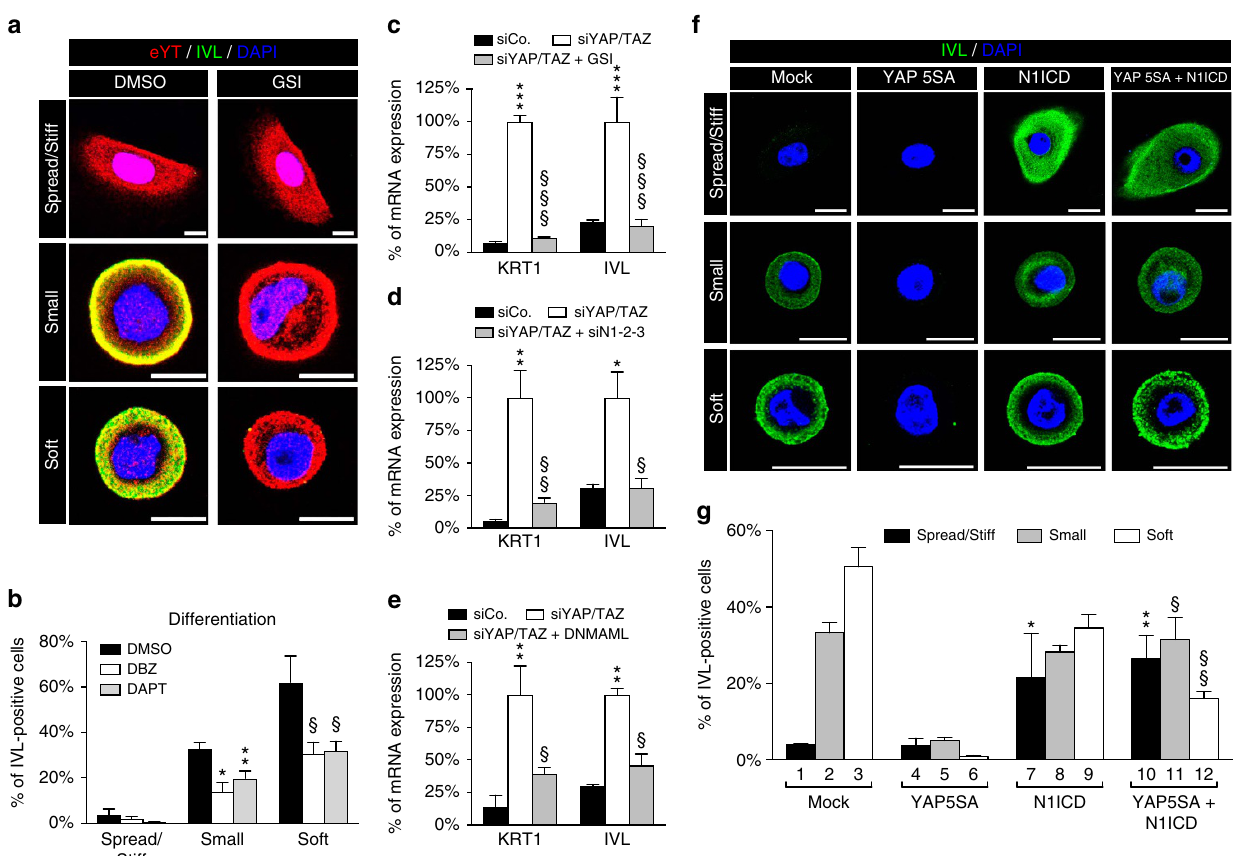
Figure 5 | Notch is epistatic to YAP/TAZ and required for mechano-induced epidermal SC differentiation. ( a , b ) nHEK cells were seeded for 24h on fibronectin-coated coverslips (spread/stiff), fibronectin islands of 300 m m 2 (small) or fibronectin-coated hydrogels of 1kPa (soft) and concomitantly treated with control vehicle (DMSO) or with two independent g -secretase inhibitors (GSIs; DAPT, 20 m M; DBZ, 2.5 m M). ( a ) Confocal images of cells plated as described and stained for endogenous YAP/TAZ (eYT, red), Involucrin (IVL, green) and nuclear compartment (DAPI, blue). Representative images of cells treated with control vehicle (DMSO) or DBZ (GSI) are shown. Scale bar: 20 m m. ( b ) Quantitation of differentiation of data shown in a (as in Figs 1 and 2). Bars represent mean þ s.d. ( n ¼ 3 independent experiments. * P ¼ 0.009 and ** P ¼ 0.0003 compared to DMSO-treated cells on small, y P o 0.0001 compared to DMSO-treated cells on soft; two-way analysis of variance (ANOVA)). ( c – e ) nHEK cells transfected with control (siCo.) or YAP/TAZ siRNAs (siYAP/TAZ) were either treated with DBZ GSI ( c ), cotransfected with a combination of siRNAs targeting Notch1, Notch2 and Notch3 receptors (siN1-2-3) ( d ) or infected with a doxycycline-inducible lentiviral vector encoding the dominant-negative form of MAML1 (DNMAML) ( e ). After 48h from siRNA transfection, cells were analysed by qRT–PCR for KRT1 and IVL . Data were normalized to the control-treated siYAP/TAZ-transfected cells (white bar). Bars represent mean þ s.d. (* P o 0.01, ** P o 0.001, *** P o 0.0001 compared to siCo; y P o 0.01, yy P o 0.001, yyy P o 0.0001 compared to siYAP/TAZ; two-way ANOVA). See Methods section for reproducibility of experiments. ( f ) Confocal images showing representative staining for IVL of nHEK cells infected with the indicated constructs and plated on spread/stiff, small or soft conditions. Scale bar: 20 m m. ( g ) Quantitation of differentiation of nHEK cells treated and stained as in panel ( f ). Only infected cells were scored for the presence of the Involucrin staining. Bars represent mean þ s.d. ( n ¼ 3 independent experiments. * P r 0.005 lane 7 versus lane